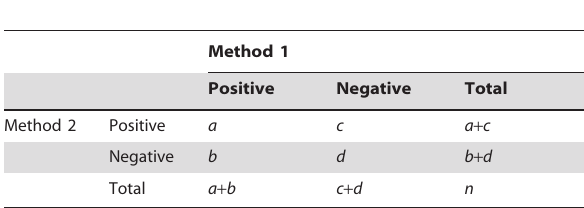
Table 1. Example of Summary Table for Evaluation of Percent